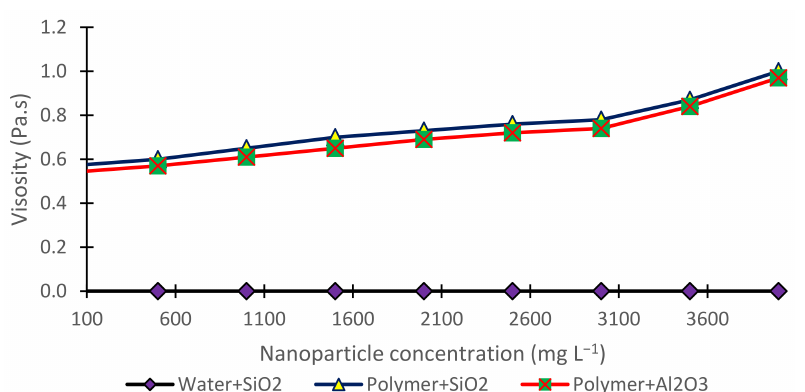
Figure 4. Viscosity measurement in the presence of different nanoparticle concentrations.